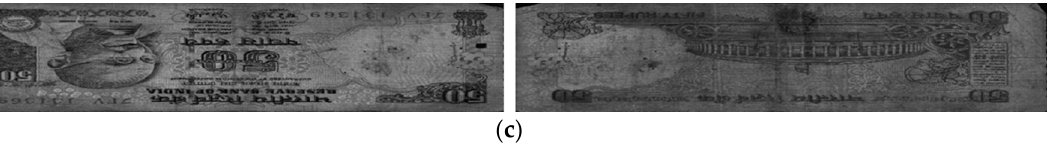
Figure 5. Example of banknote images in the INR database with fitness levels of ( a ) Fit, ( b ) Normal, and ( c ) Unfit.